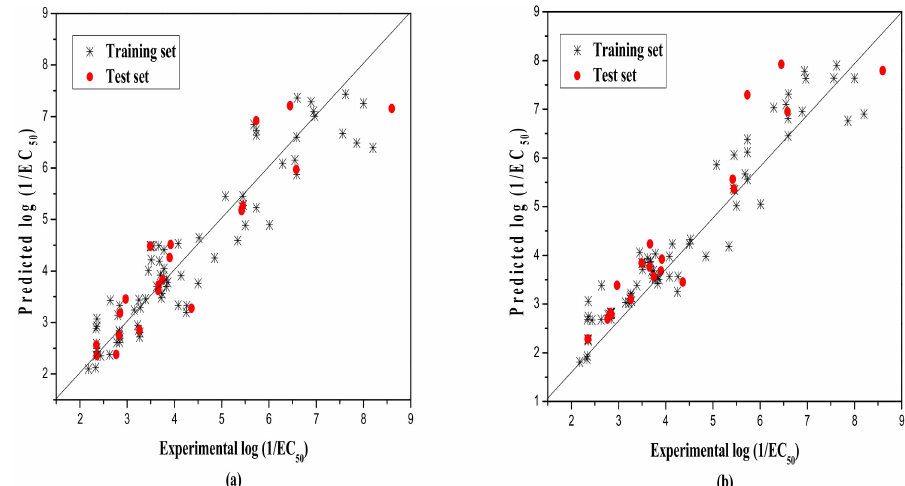
Figure 1. Plot of the predicted versus experimental − log(EC 50 ) including the training and the test set by MLR model ( a ) and by RBFNN model ( b ).